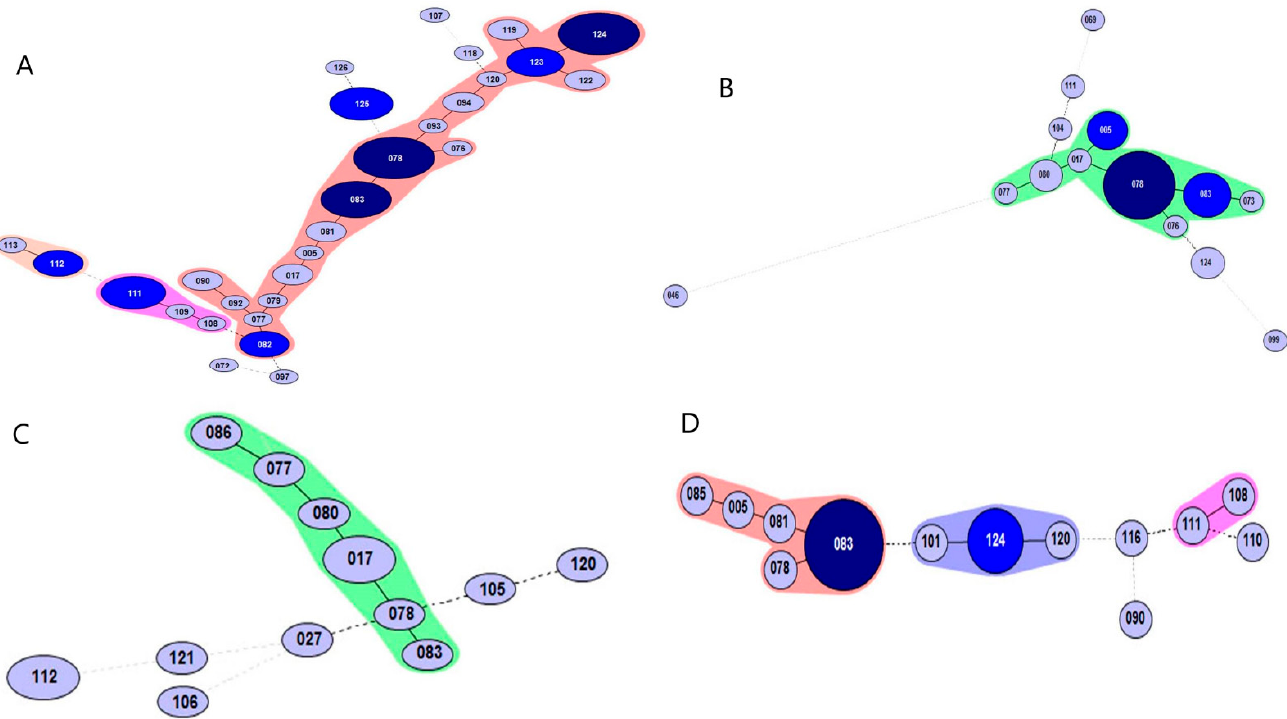
Figure 2. Minimum spanning tree analysis of Clostridioides difficile polymerase chain reaction ribotype 017 isolates charac- terized by multilocus variable-number tandem-repeat analysis (MLVA) over 5 years. Each circle represents a unique MLVA type. The numbers between the circles represent the summed tandem-repeat differences (STRDs) between MLVA types. Clonal complexes (CC-A to CC-E) are marked clusters containing two or more isolates whose MLVA types gener- ated an STRD ≤ 2.